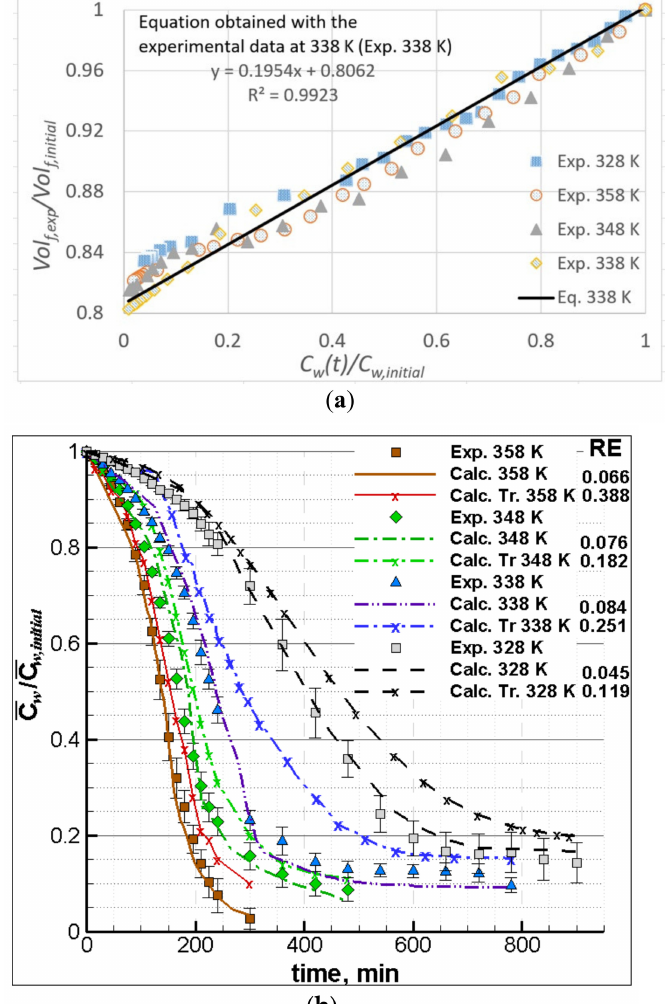
Figure 2. ( a ) Moisture ratio vs. volume ratio for the fruit drying. Black solid line (338 K) and equation correspond to linear equation used to calculate the volume change in the simulations. ( b ) Comparison between experimental (Exp.) and calculated drying curves at different air inlet temperatures using the traditional mathematical model without shrinkage (Calc. Tr.) and the proposed model that include shrinkage